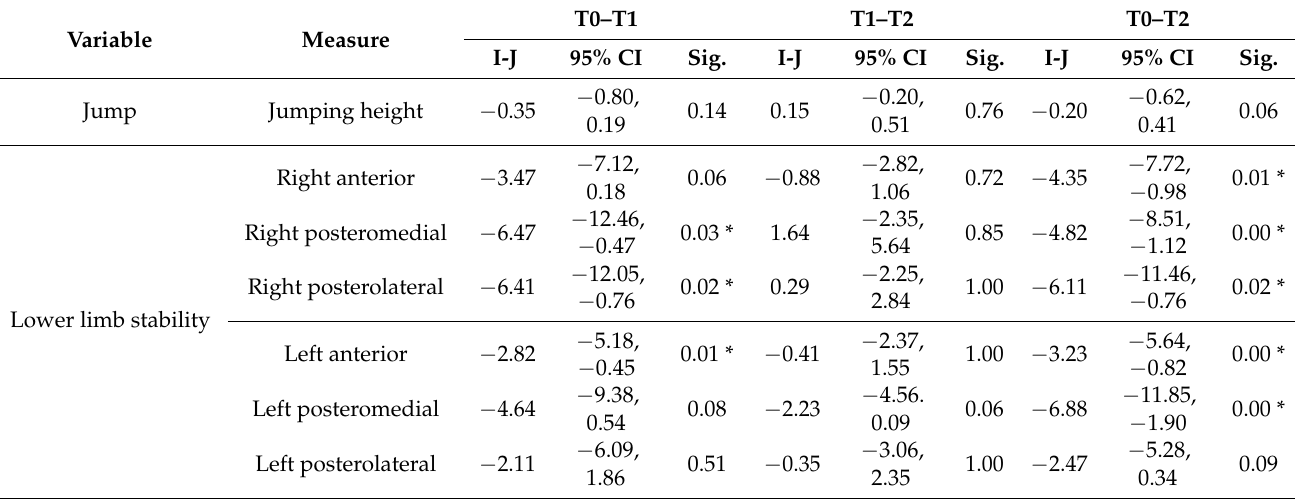
Table 5. Pairwise comparison analysis, mean difference (and 95% confidence interval) between the three evaluations performed in each study group.